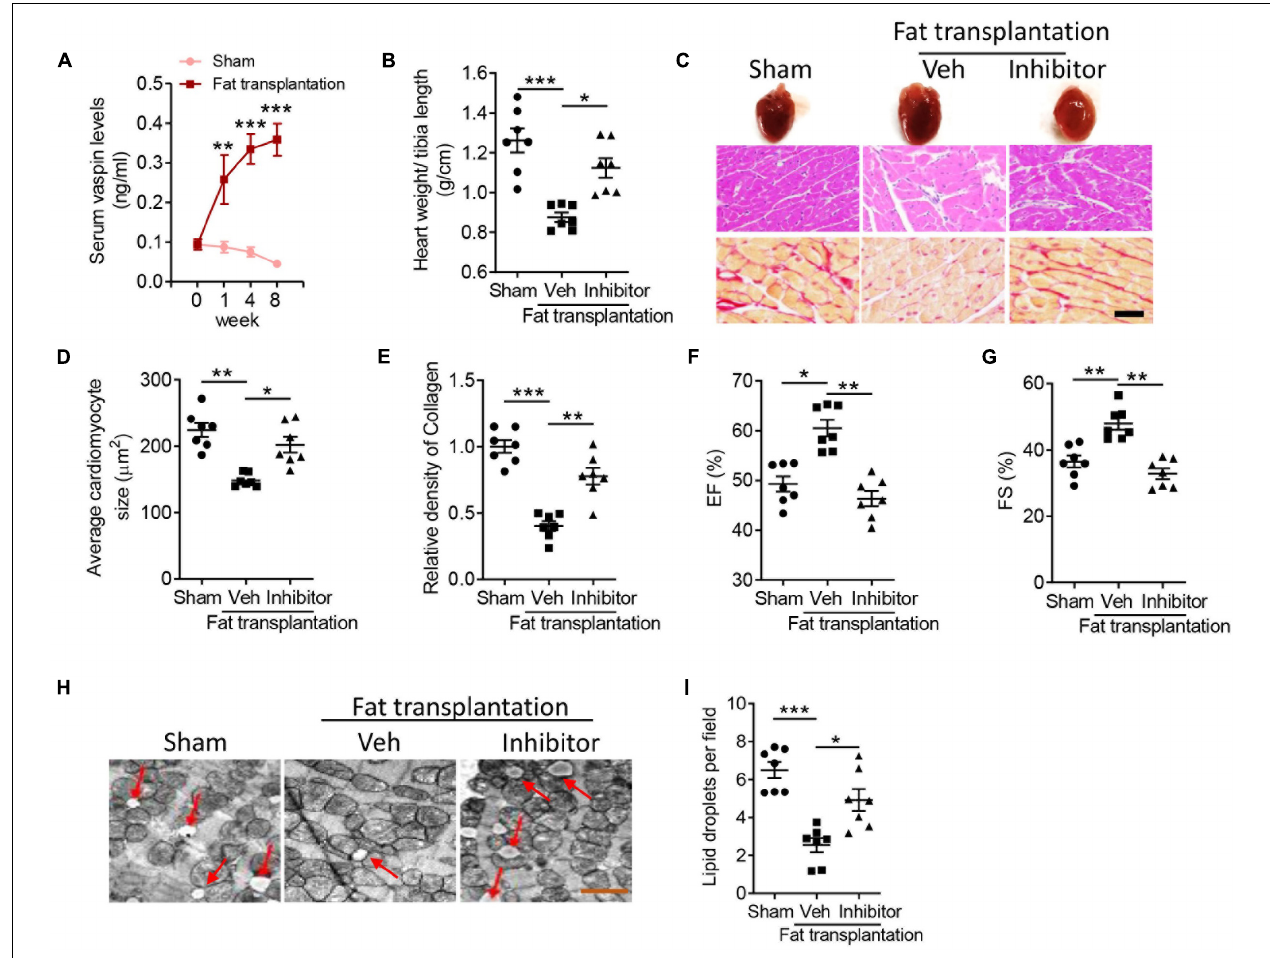
FIGURE 4 | Blockage of vaspin reverses the cardioprotective benefits of fat transplantation in A-ZIP/F-1 lipoatrophic mice. Sixteen-week A-ZIP/F-1 mice were subcutaneously transplanted with 0.9 g of visceral fat from C57BL/6J mice and locally injected with 1 10 9 lentivirus-encoding vaspin siRNA or control siRNA for 8 weeks. (A) The serum levels of vaspin in mice treated with recombinant vaspin protein for 0, 1, 4, and 8 weeks. (B) The ratio of heart weight/tibia length. (C–E) Representative images of whole hearts, and cardiac slides were stained with hematoxylin and eosin or Sirius red staining solution (C) , and quantitative analysis of average cardiomyocyte size (D) and relative density of collagen (E) . Scale bar = 20 µ m. (F,G) Echocardiographic analysis of mouse cardiac EF (F) and FS (G) . (H,I) The representative images of cardiac mitochondria (H) and quantitative analysis of lipid droplets (I) . Results are shown as mean ± SEM, and n = 7 mice/group. * p < 0.05, ** p < 0.01, *** p <